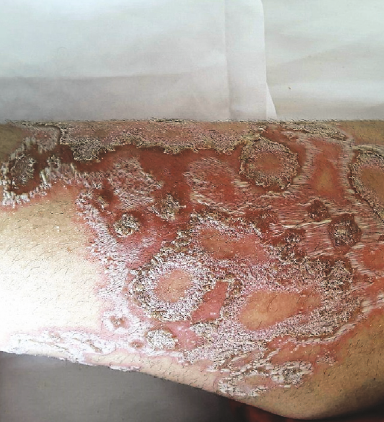
Figure 1: Annular lesions of pustular psoriasis of pregnancy on left thigh of a patient in the 36th week of the first